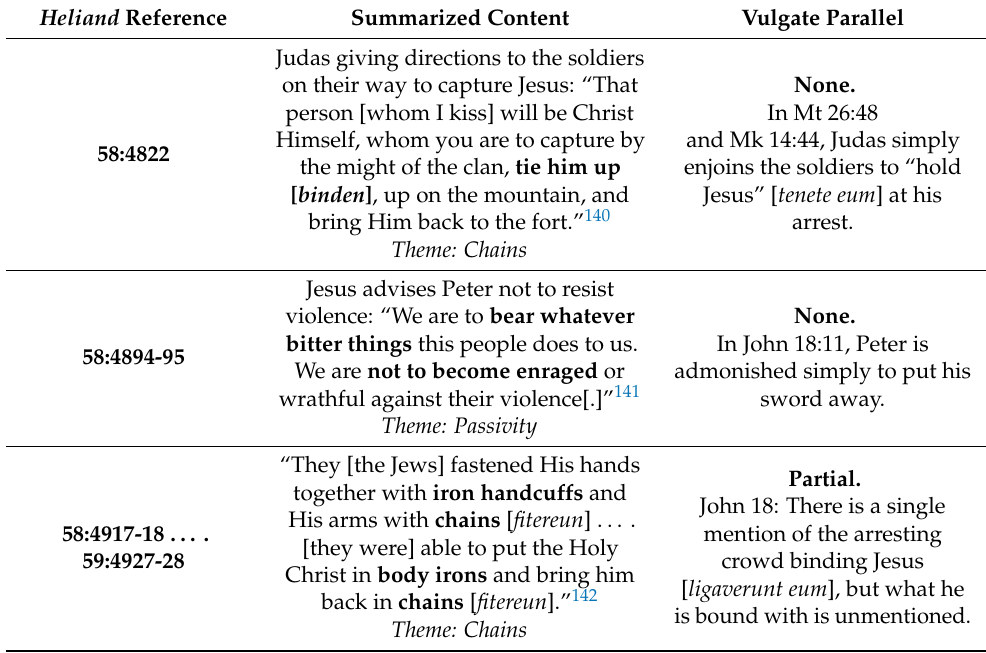
Table 2. Twin themes of Christ’s chains and passive suffering in the Heliand